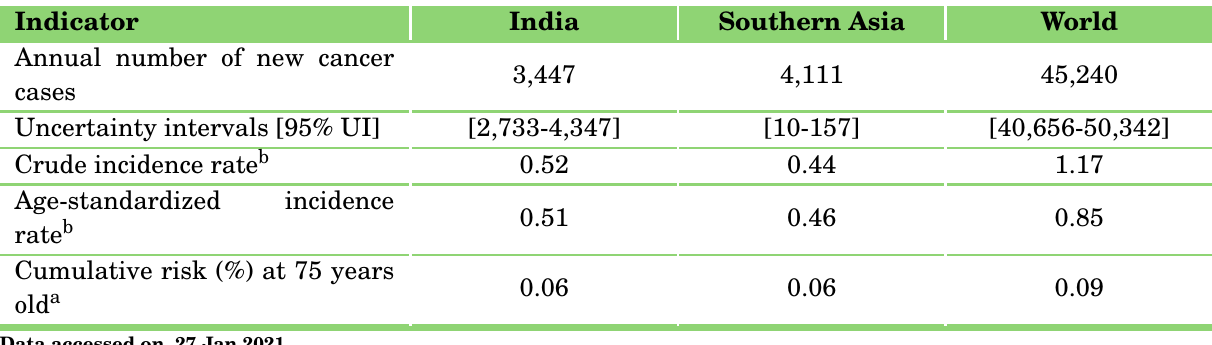
Table 9: Vulva cancer incidence in India (estimates for